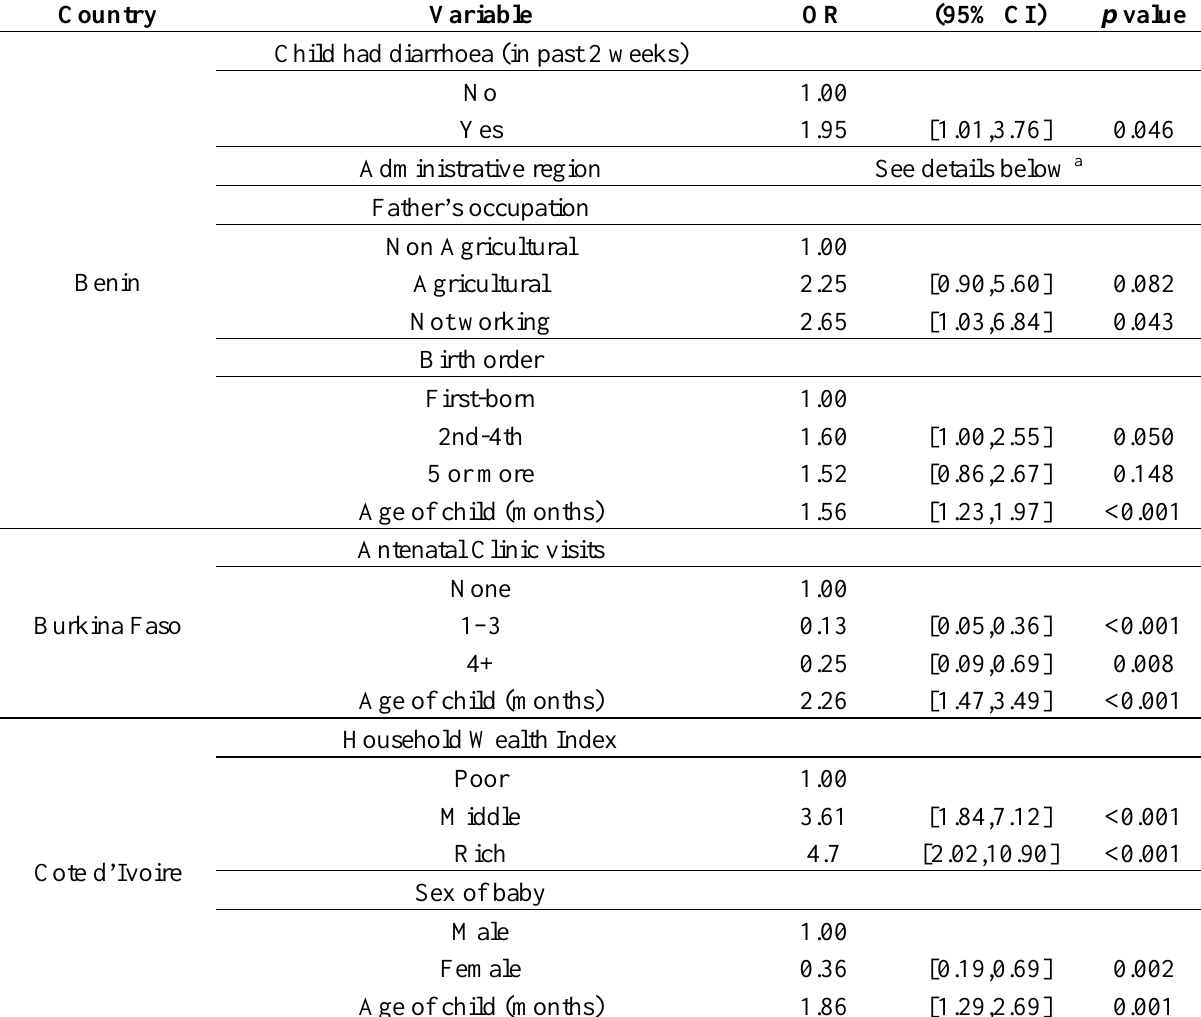
Table 3. Factors associated with early introduction of solid, semi-solid or soft foods among infants aged three to five months in seven Francophone West African countries, 2010–2013. Country Variable OR (95% CI) p